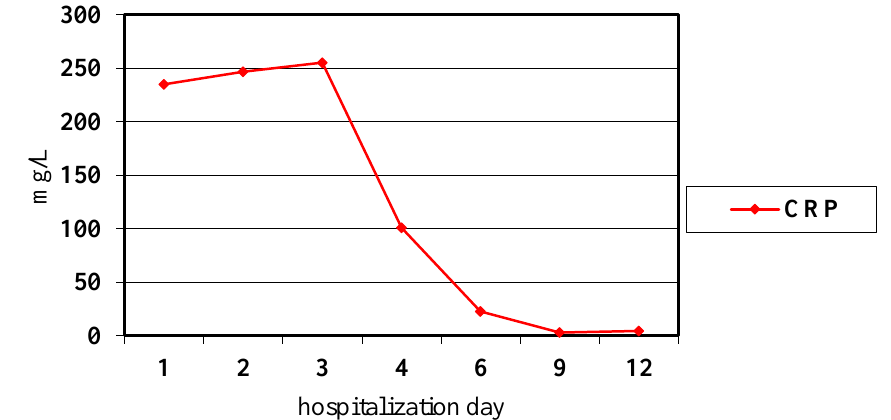
Figure 3. CRP values during observation of